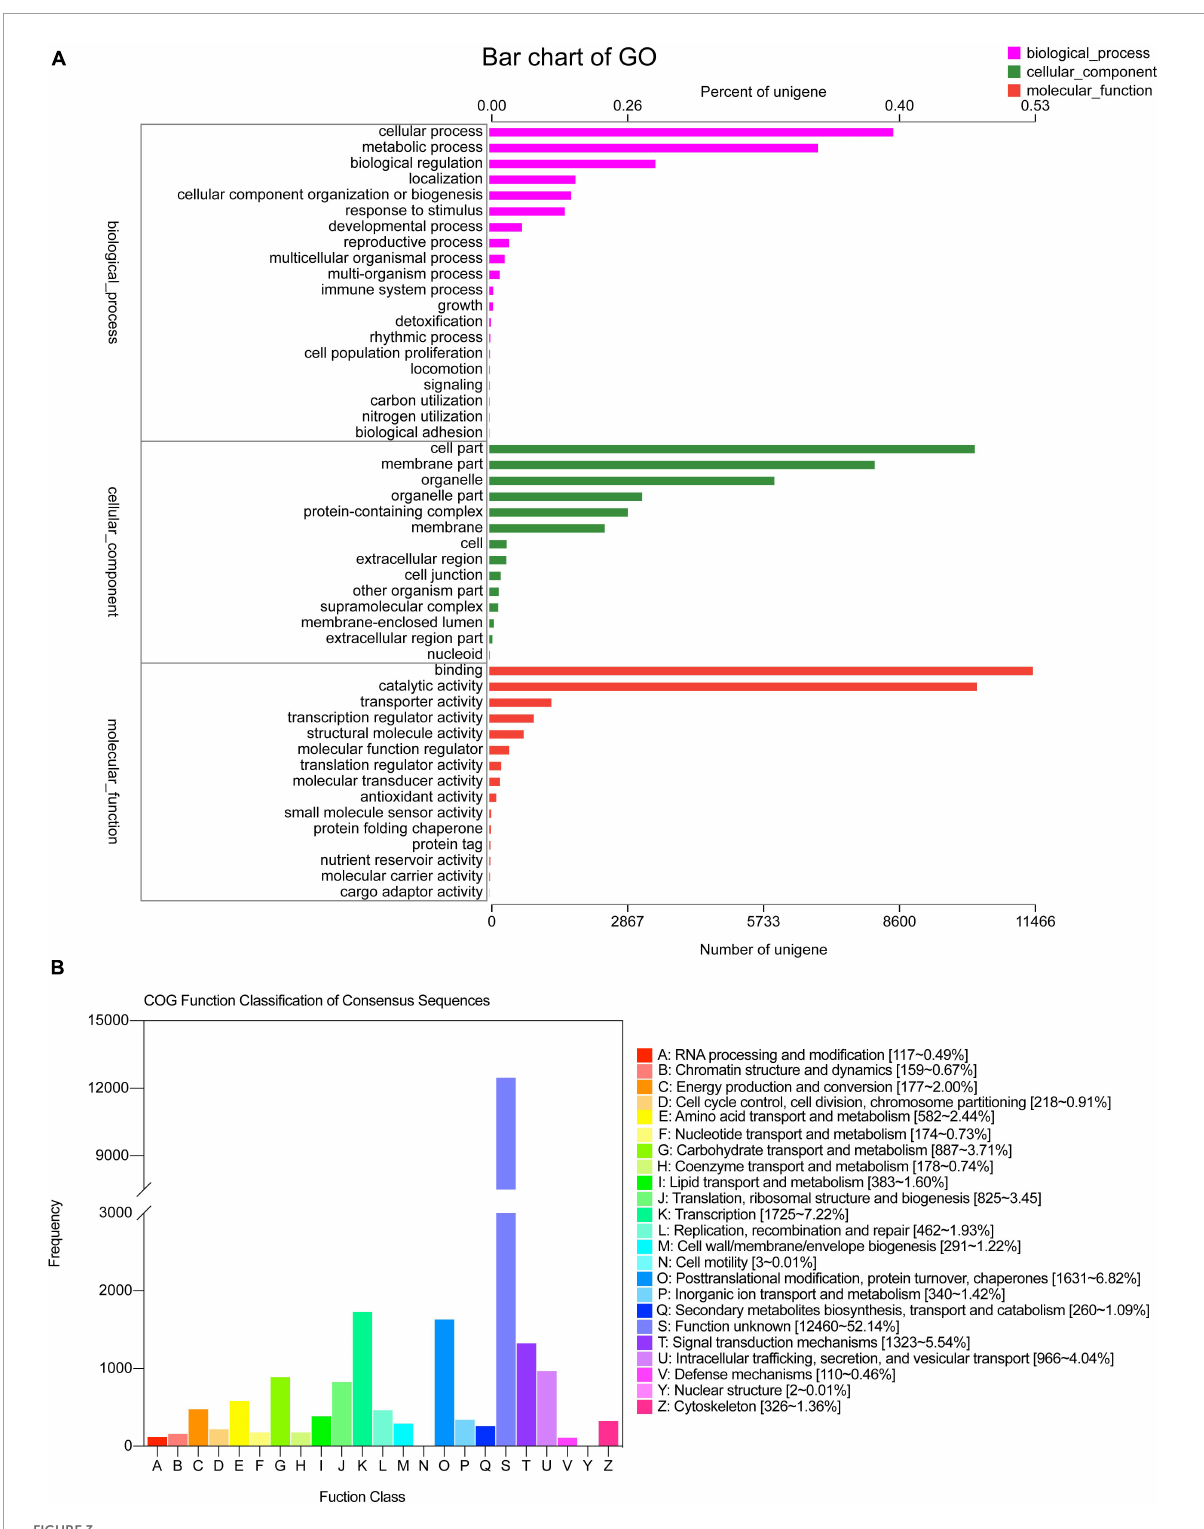
FIGURE3 GO and COG classification statistics. (A) GO, (B)